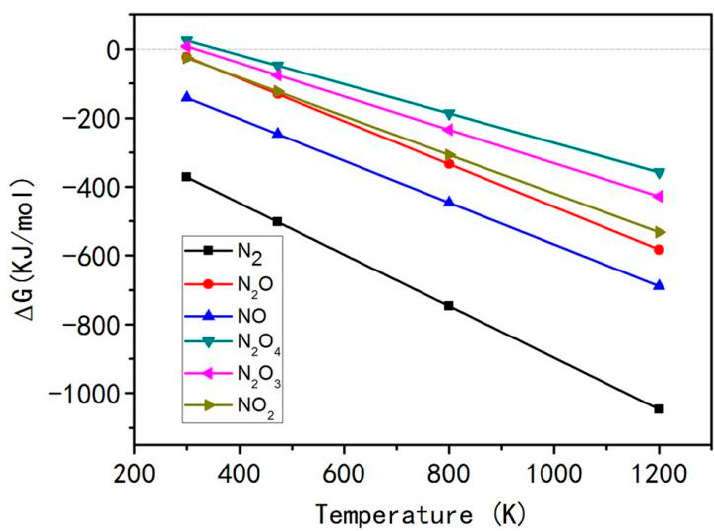
∆ G of Equations (2)–(7) for formation of various nitrogen-containing Figure 1. Δ G of Equations (2)–(7) for formation of various nitrogen-containing gases. Figure 1.